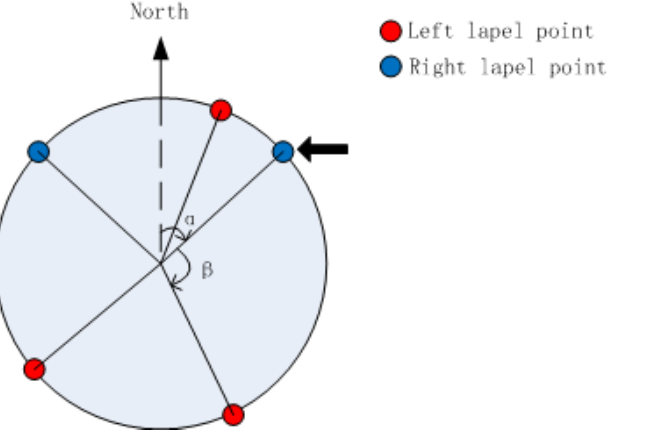
Figure 12. The angle between the North of the lapel point and the adjacent point in the clockwise direction. The current selected lapel point is the right lapel point indicated by the black arrow, and its Angle North is α , and the Angle adjacency is β